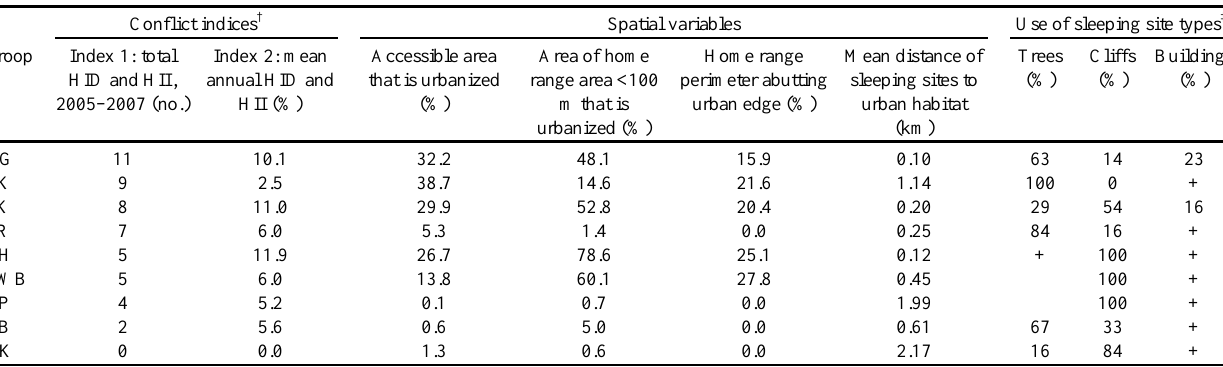
Table 2 . Measurements used to determine why some troops experience higher levels of human–baboon conflict than others, and the characteristics of the sleeping sites used by each